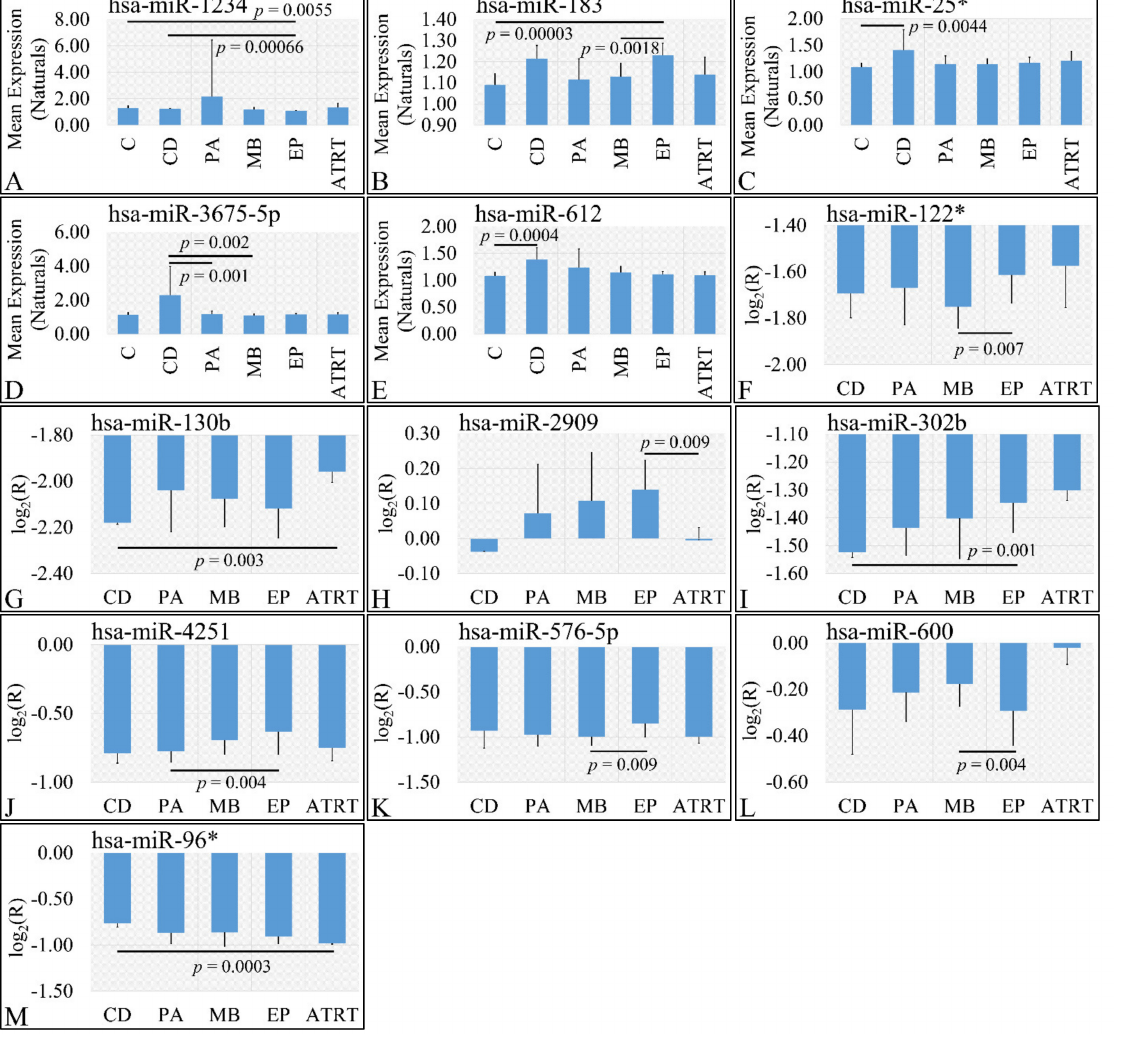
Figure 3. DE miRNAs with respect to diagnosis. Significant differences were estimated using ANOVA with Bonferroni correction. Significant differences were observed between cortical dysplasia ( n = 2) and ependymoma ( n = 7), as well as controls ( n = 13) and ependymomas ( n = 7) with respect to miR-1234 ( A ). Significant differences were observed between controls and ependymoma ( n = 7), as well as medulloblastoma ( n = 16) and ependymomas ( n = 7) with respect to